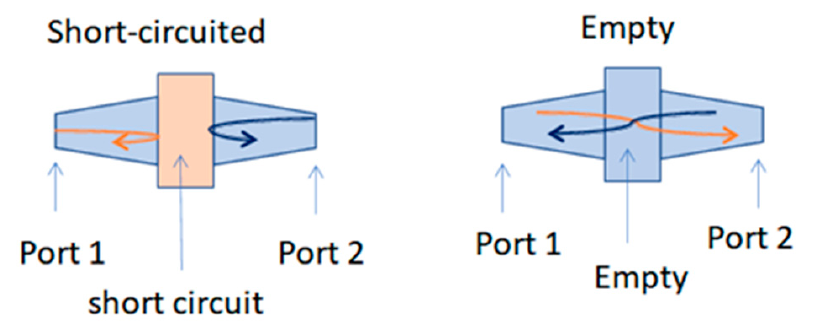
Figure 2. Description of the protocol measurements. (The orange arrow is forward propagation, and the blue one is reverse propagation).